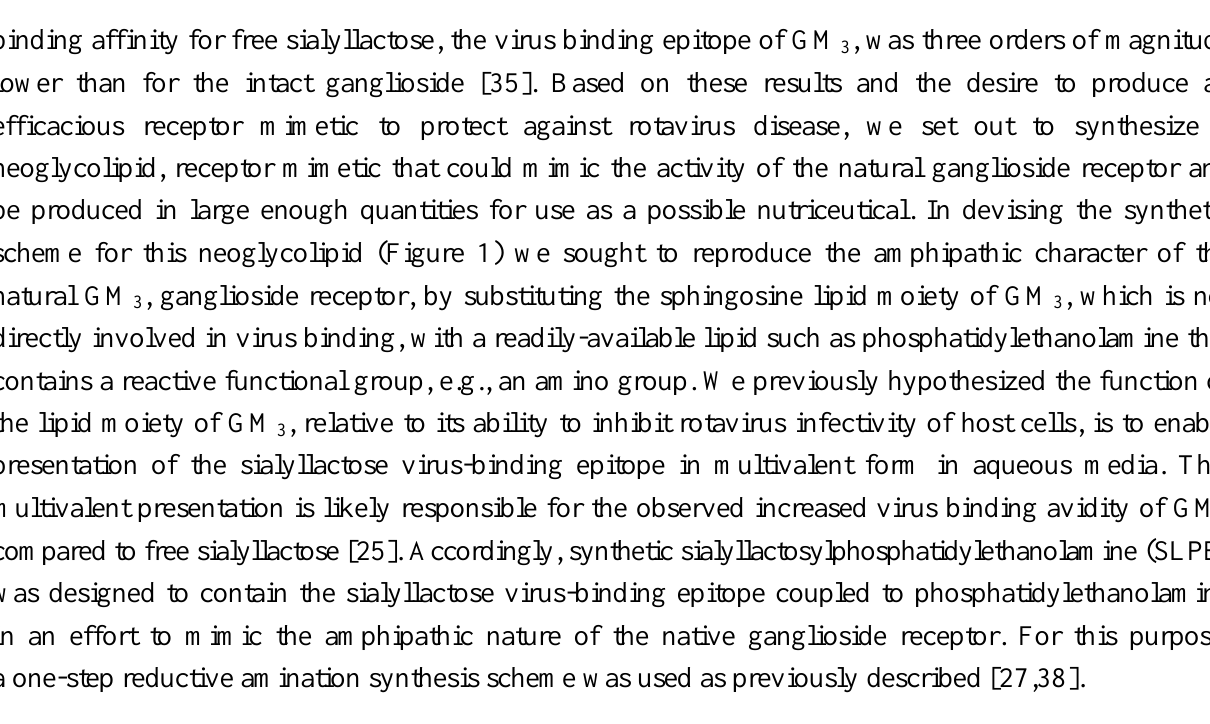
Figure 1. Scheme for synthesis of SLPE. SLPE is synthesized using a one step reductive amination to covalently couple the amino group of phosphatidylethanolamine to the anomeric carbon of the reducing end glucose residue of